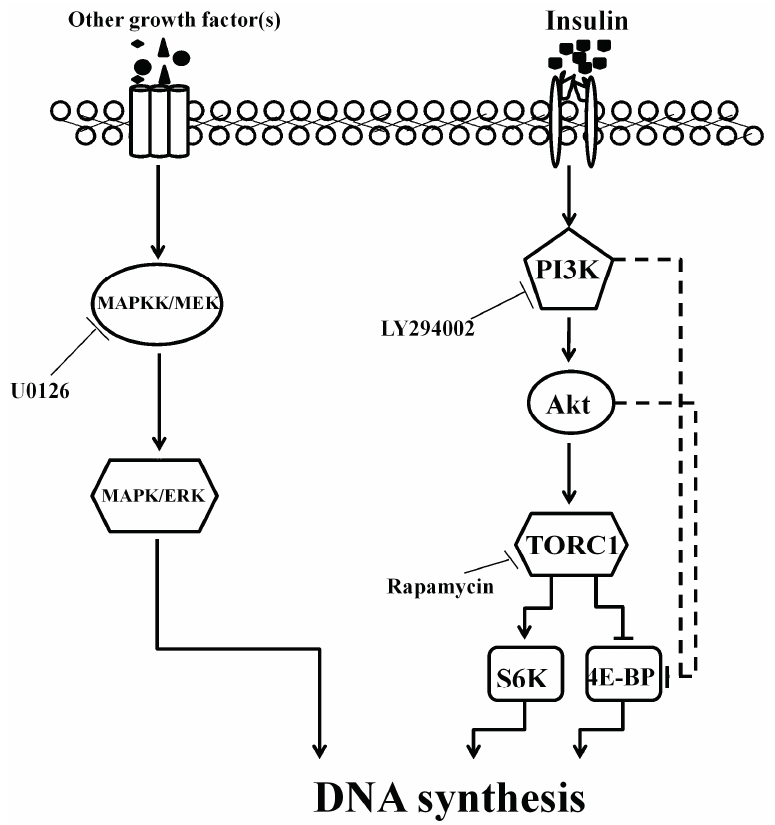
Figure 5. A predicted network that links the growth factor signaling pathways with silk gland cell DNA synthesis in the silkworm. Insulin activated silk gland DNA synthesis via PI3K/AKT/TOR signaling. MAPK/ERK signaling may be activated by other growth factor(s). Solid lines indicate demonstrable or highly likely relations; dashed lines indicate hypothetical